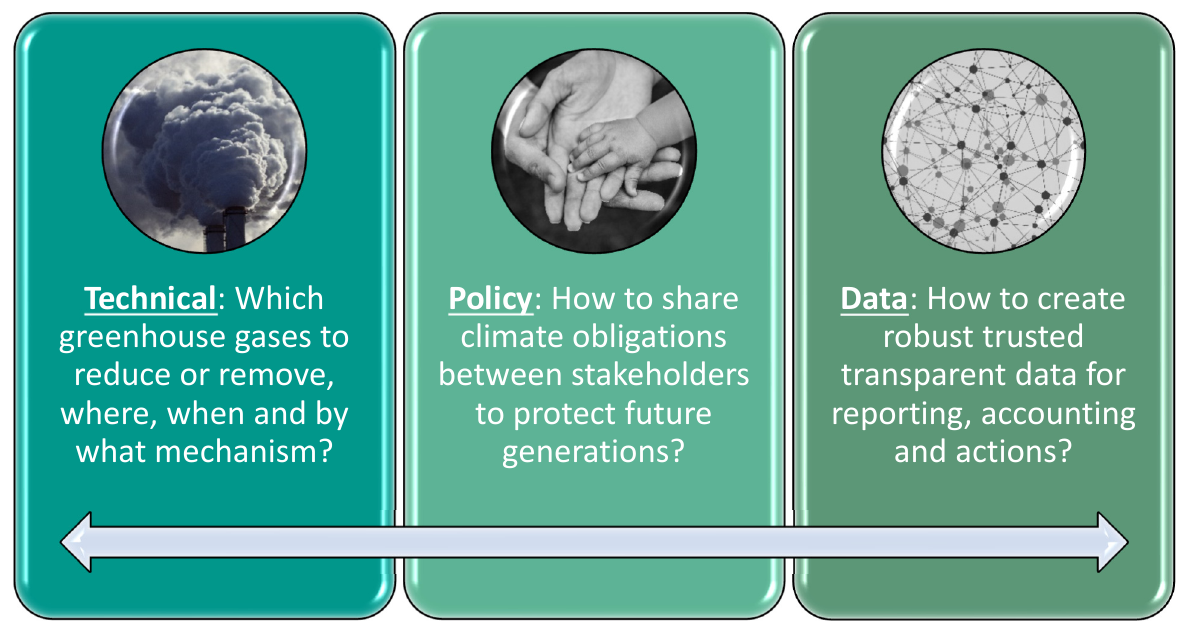
Figure 2. Three interactive buckets of LCA-embedded net-zero paradigm questions. Technical : Which greenhouse gases to remove, where and by when and what mechanism : There is no mechanism for directly capturing greenhouse gases from the atmosphere.